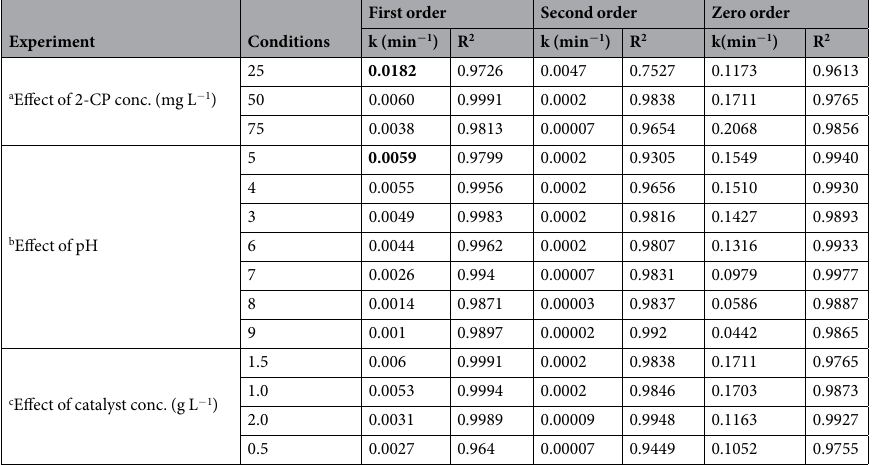
Table 1. Kinetic constant values explaining the effect of catalyst dose, pH and 2-CP concentration over ternary nanocomposite GCF1. a (Catalyst dosage: 1 g L − 1 , Solution pH = 5). b (2-CP initial concentration: 50 mg L − 1